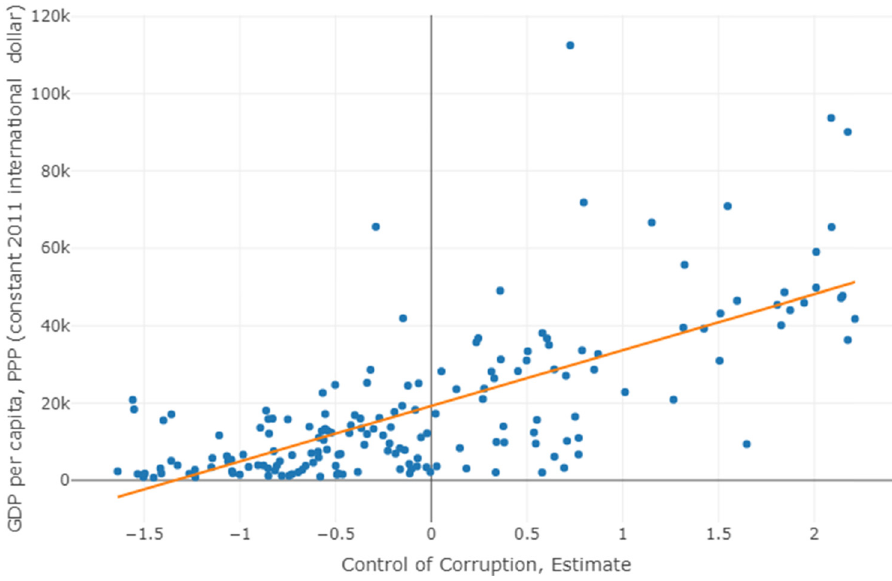
Figure 1: Control of corruption vs real GDP. Source: The Quality of Government Institute.